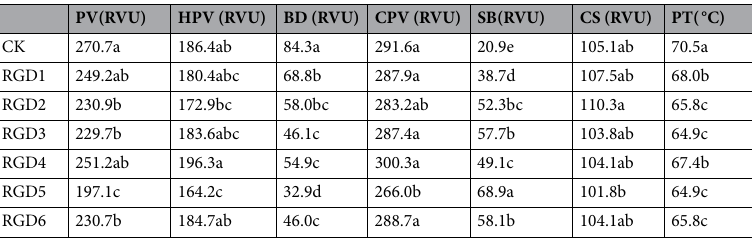
Table 1. Pasting Properties of flour from RGD1-6 by Rapid ViscoAnalyser. Rapid Visco Units (RVU), peak viscosity (PV), hot pasteviscosity (HPV), breakdownviscosity (BD), cool paste viscosity (CPV), setback viscosity(SB), consistency viscosity (CS) and pastingtemperature (PT). Different letter indicates significant difference (P <